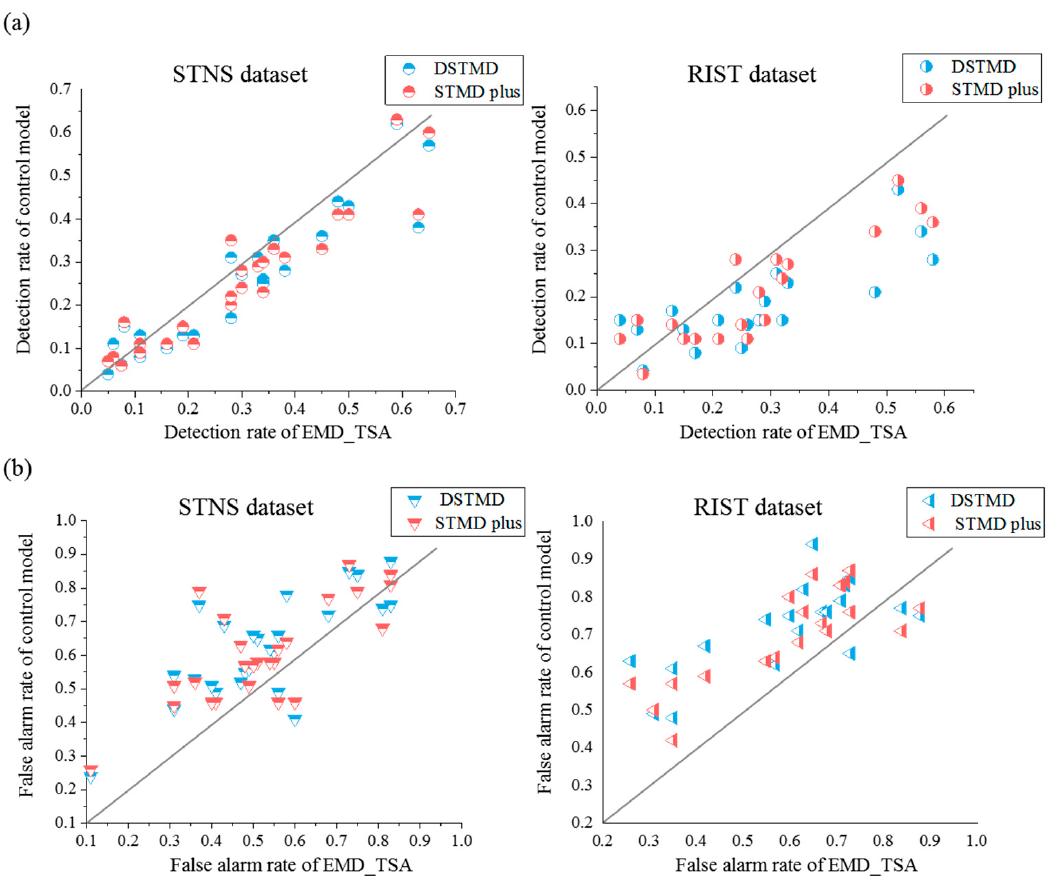
Figure 9. Scatterplot for the performance of EMD_TSA versus DSTMD and STMD plus model on STNS and RIST dataset. The diagonal line displays the locus of equal value. ( a ) The detection rate. ( b ) The false-alarm rate.